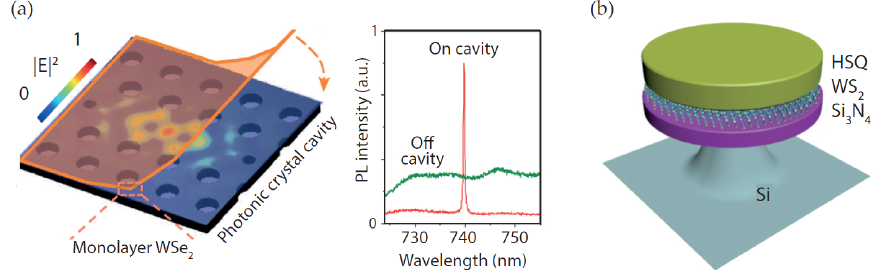
Figure 6. ( a ) Photonic crystal cavity WSe 2 nanolaser. The color profile shows the fundamental cavity mode before a WSe 2 monolayer is transferred on the structure. The on-cavity excitation photoluminescence spectrum (red) shows a narrow emission line compared to off-cavity excitation